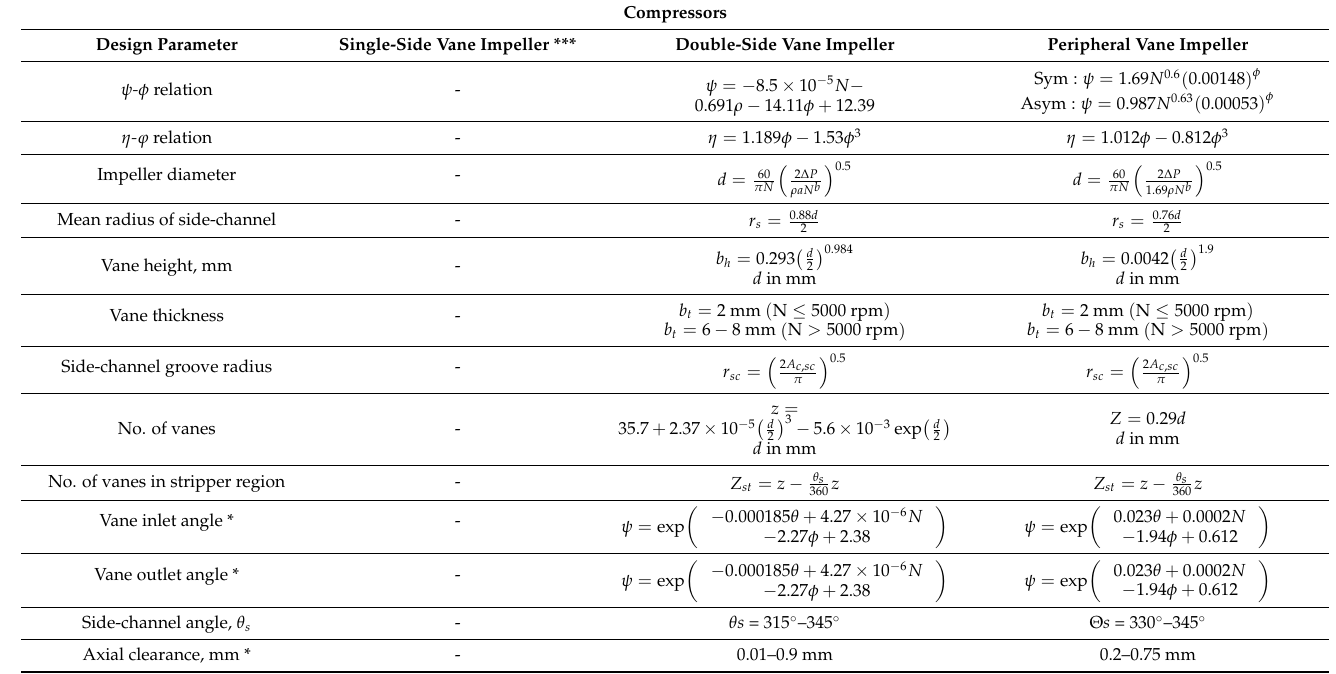
Table 3. Consolidated Table of Correlations for Regenerative Flow Compressor